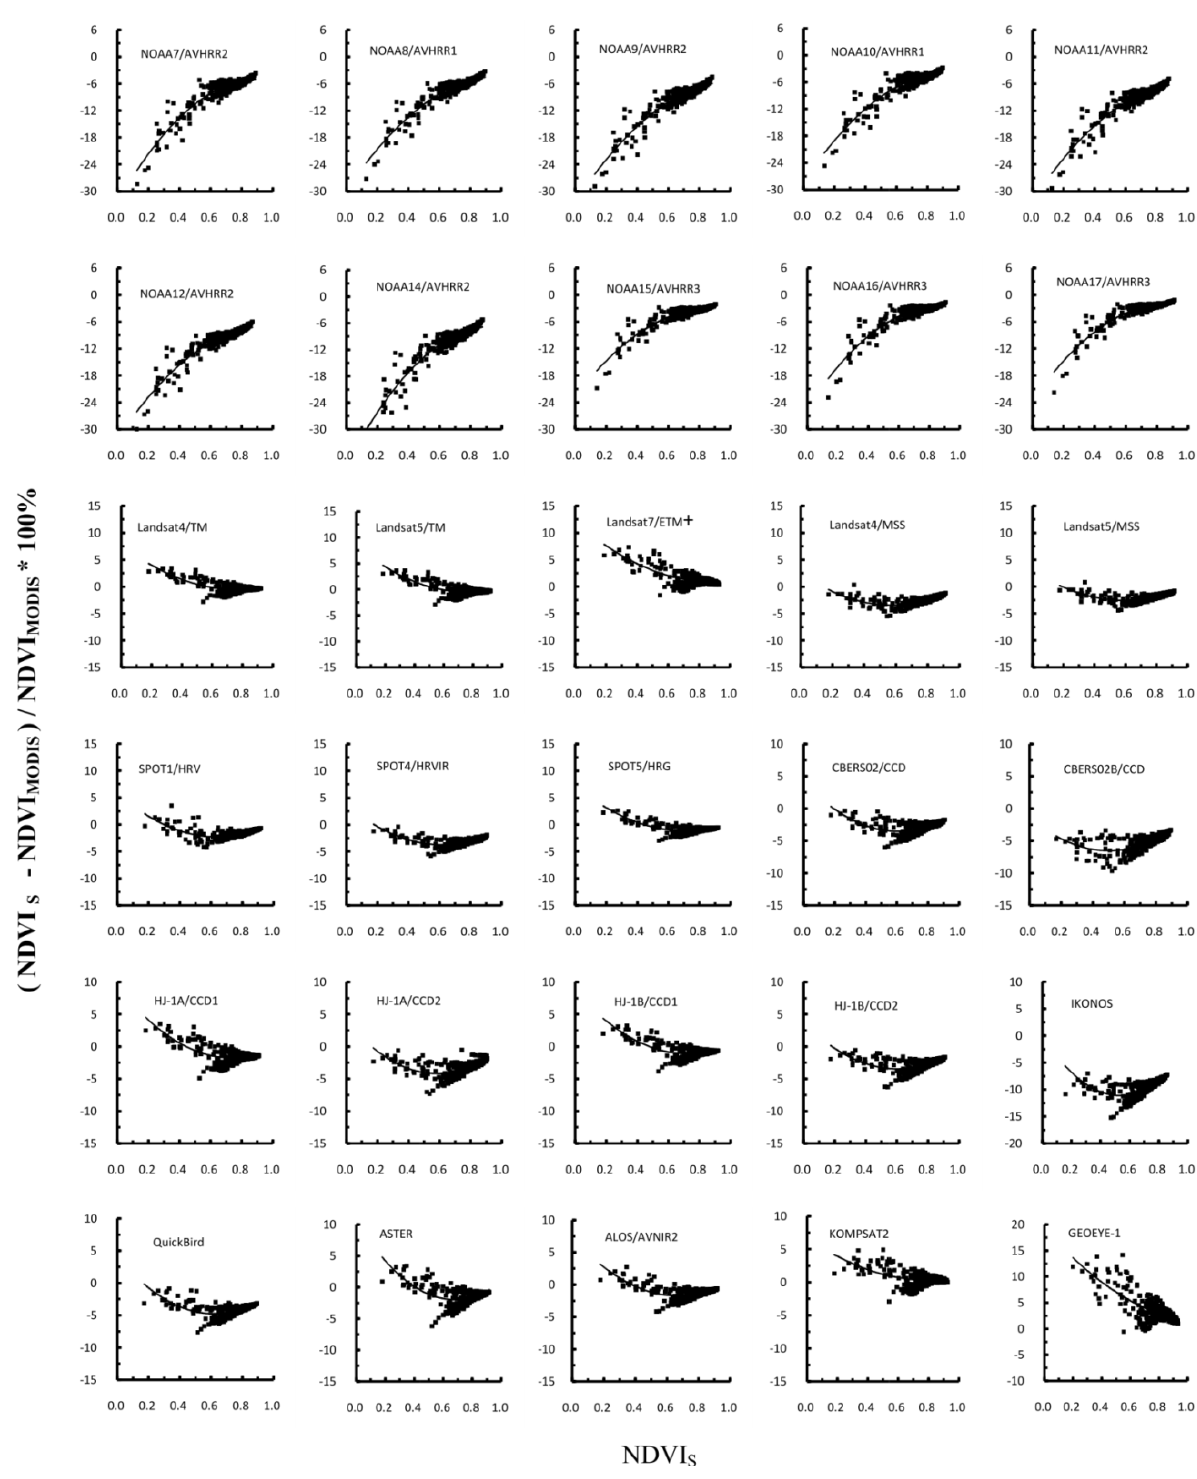
Figure 7. Relative percentage differences in NDVI with respect to Terra MODIS. All data points are plotted versus NDVI of particular sensor. Parameters of fitting curves are given in Table